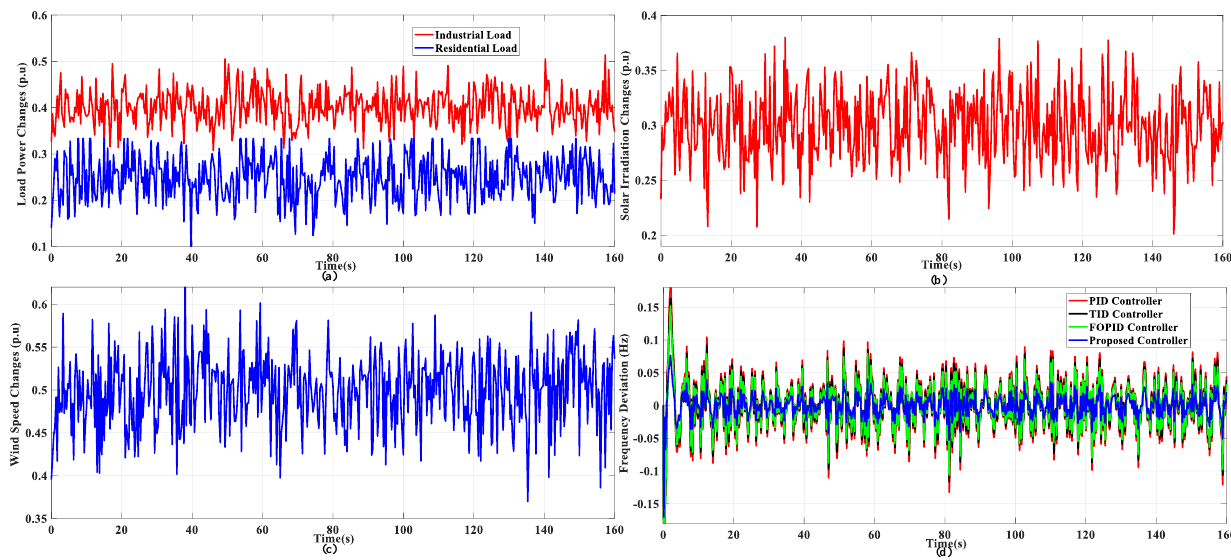
Figure 9. Perturbations and simulation result for scenario 5. ( a ) Load disturbances. ( b ) Wind speed changes. ( c ) Solar irradiation changes. ( d ) Obtained frequency